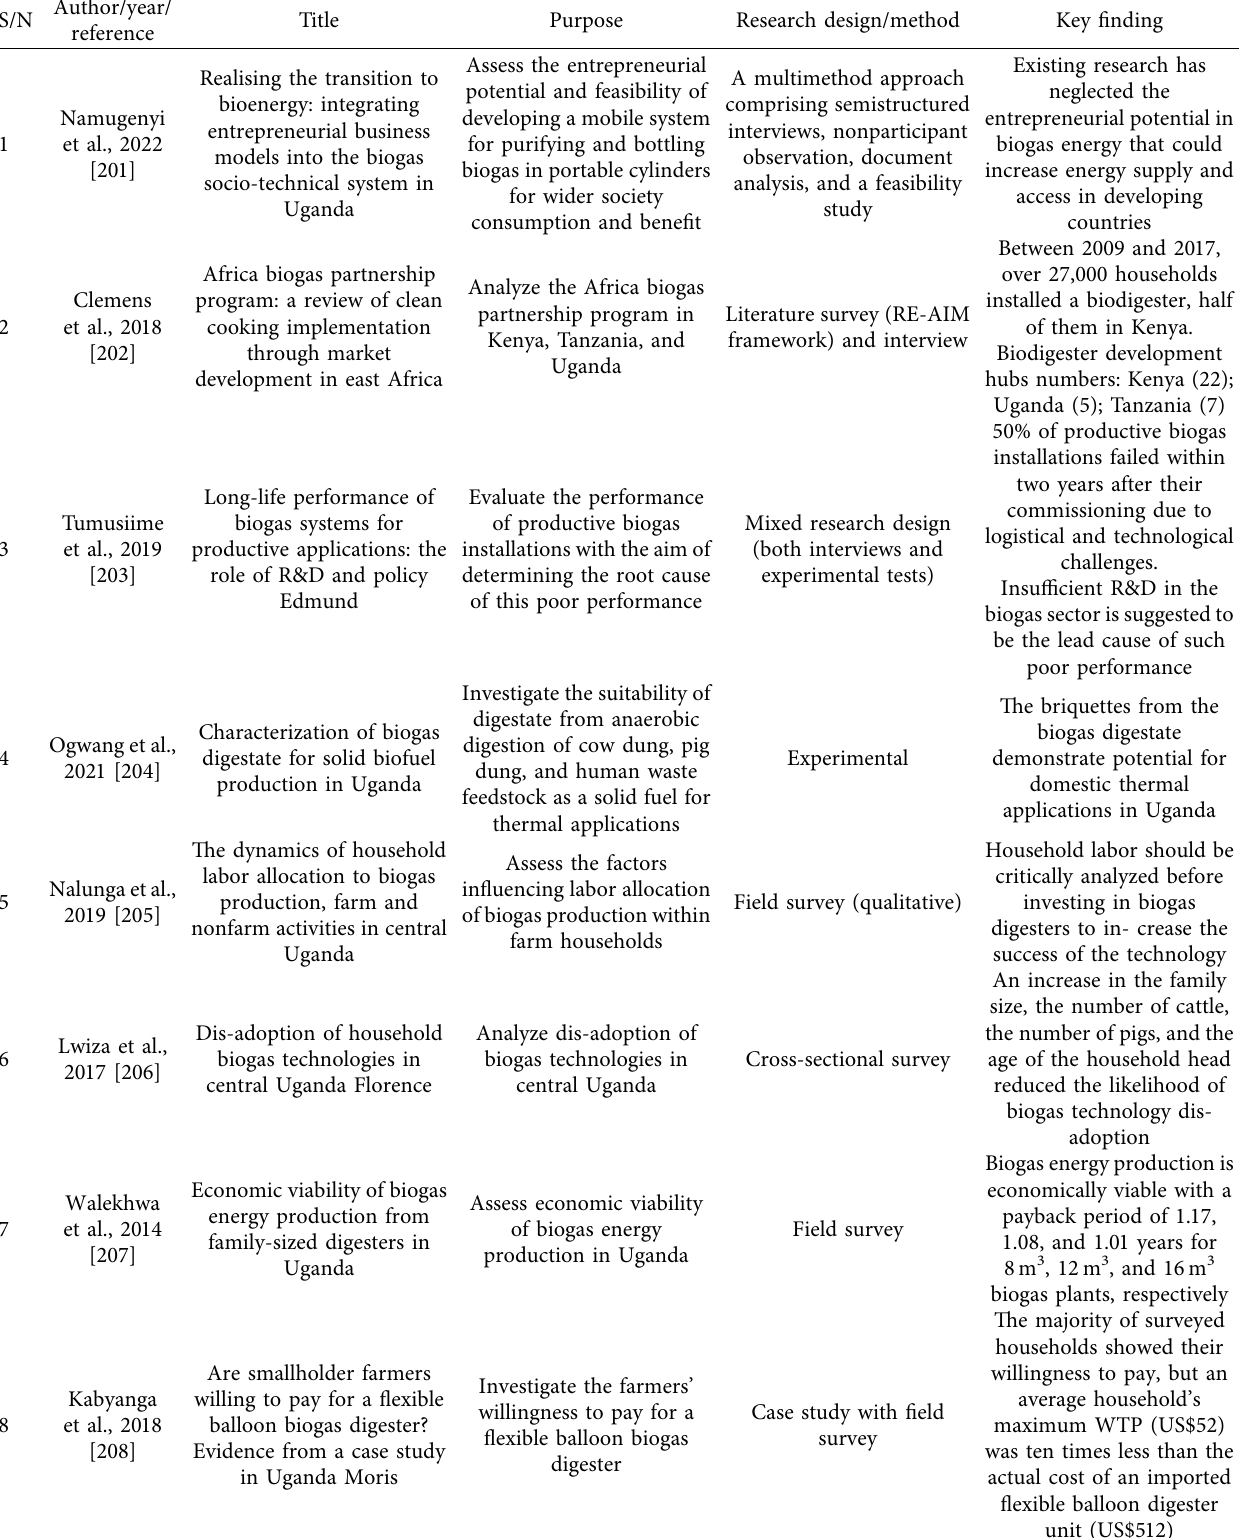
Table 11: A summary of previous studies on biogas energy in